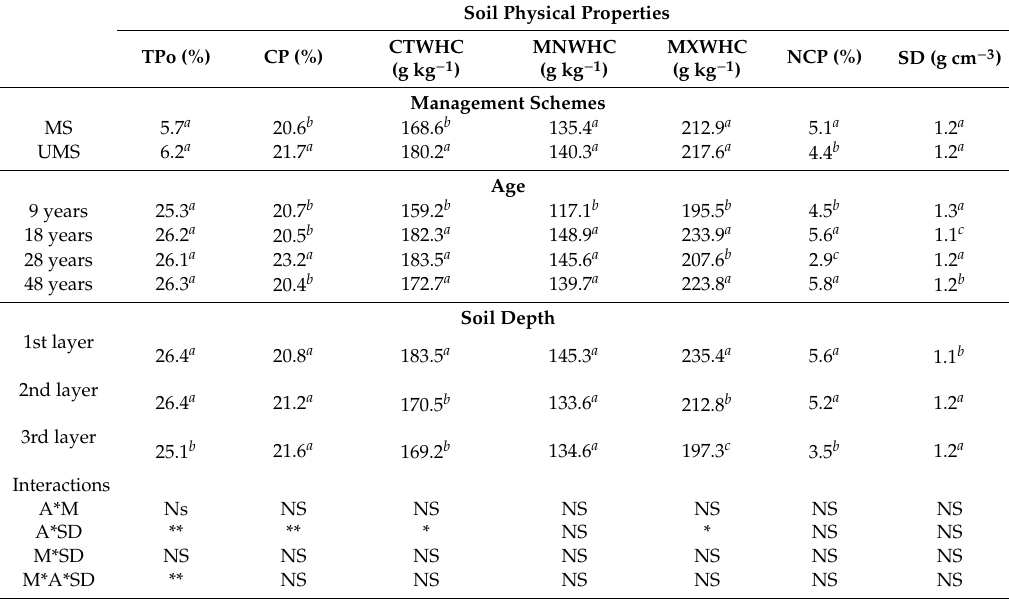
Table 4. Soil physical properties in di ff erent stand age groups and management treatments in Masson pine ( P. massoniana ) plantations. Di ff erent lower-case letters within columns indicate significant di ff erences among